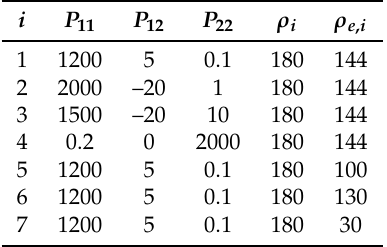
Table 3. i -th controller